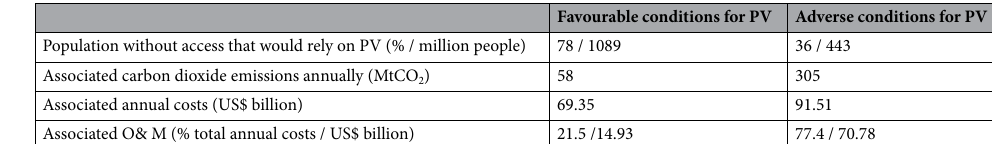
Table 3. Population relying on PV, the associated carbon dioxide emissions, and associated annual costs. Source: Authors’ compilation based on the analysis.